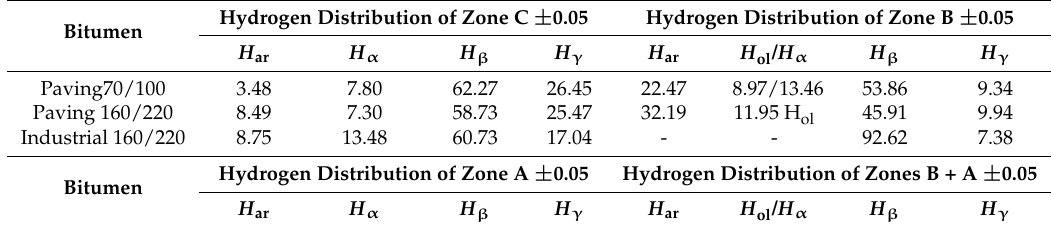
Figure 6. The 1 H-NMR spectra of Industrial 2 160/220 bitumen in CCl 4 : ( a ) neat bitumen; ( b ) maltene fraction; and ( c ) asphaltene fraction.